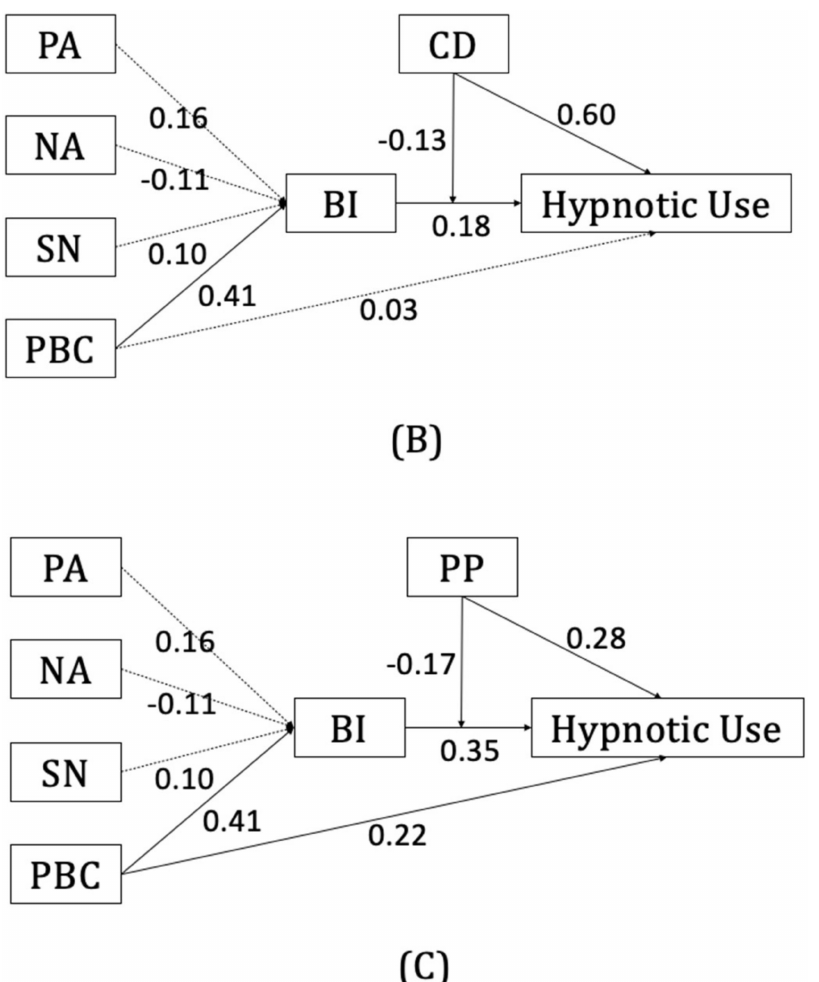
Figure 1. The visual illustration of coefficients of the Theory of Planned Behavior (TPB) constructs and moderation effect of craving on hypnotic use: ( A ) The predicting values of TPB constructs on hypnotic use; ( B ) The moderation effect of Compelling Desire (CD) on the association between behavioral intention and hypnotic use; ( C ) The moderation effect of Preoccupation and Pleasurable feelings (PP) on the association between behavioral intention and hypnotic use. (PA: positive attitude; NA: negative attitude; SN: subjective norm; PBC: perceived behavioral control; BI: behavioral